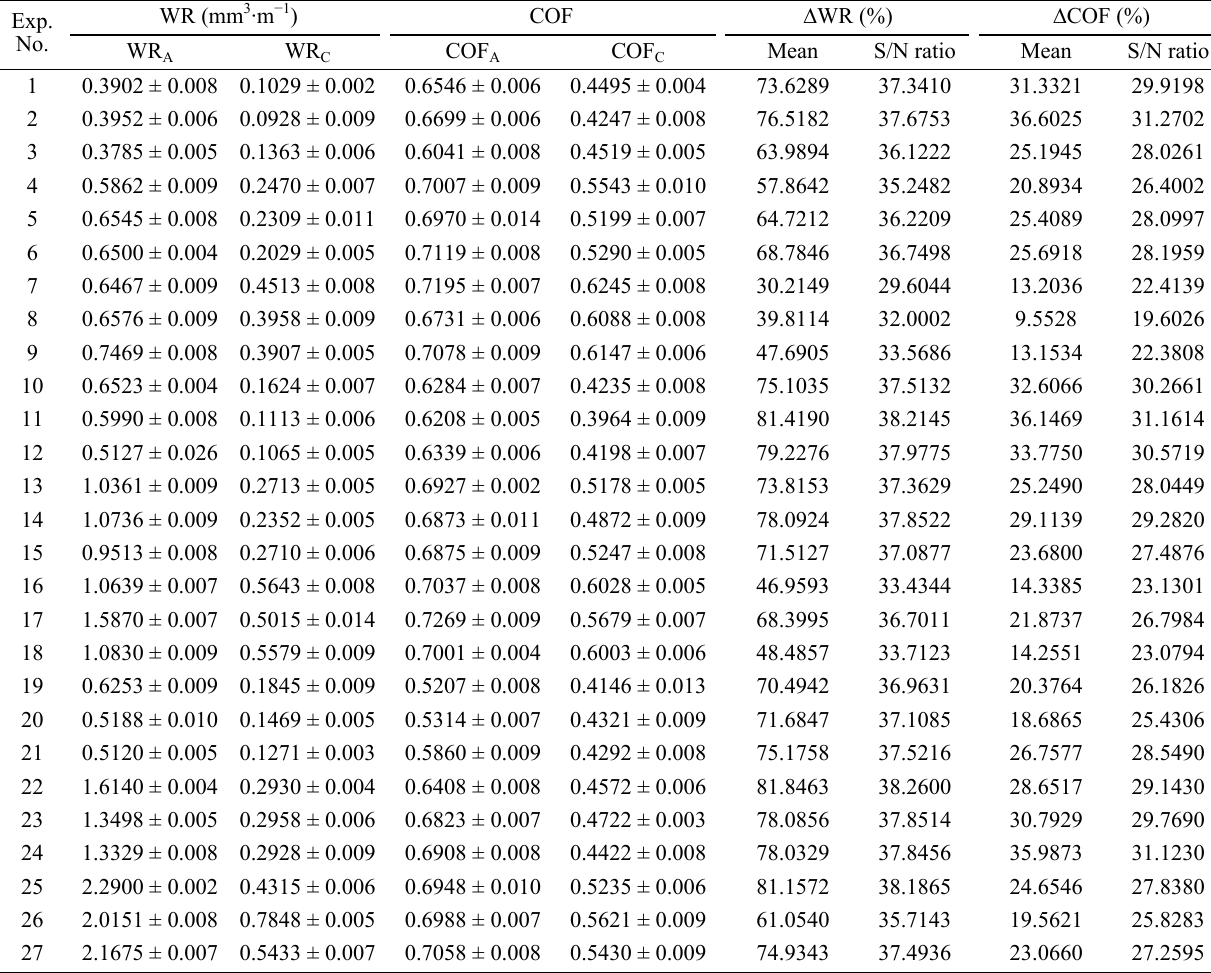
Table 3 Experimental results using Taguchi L 27 orthogonal array.